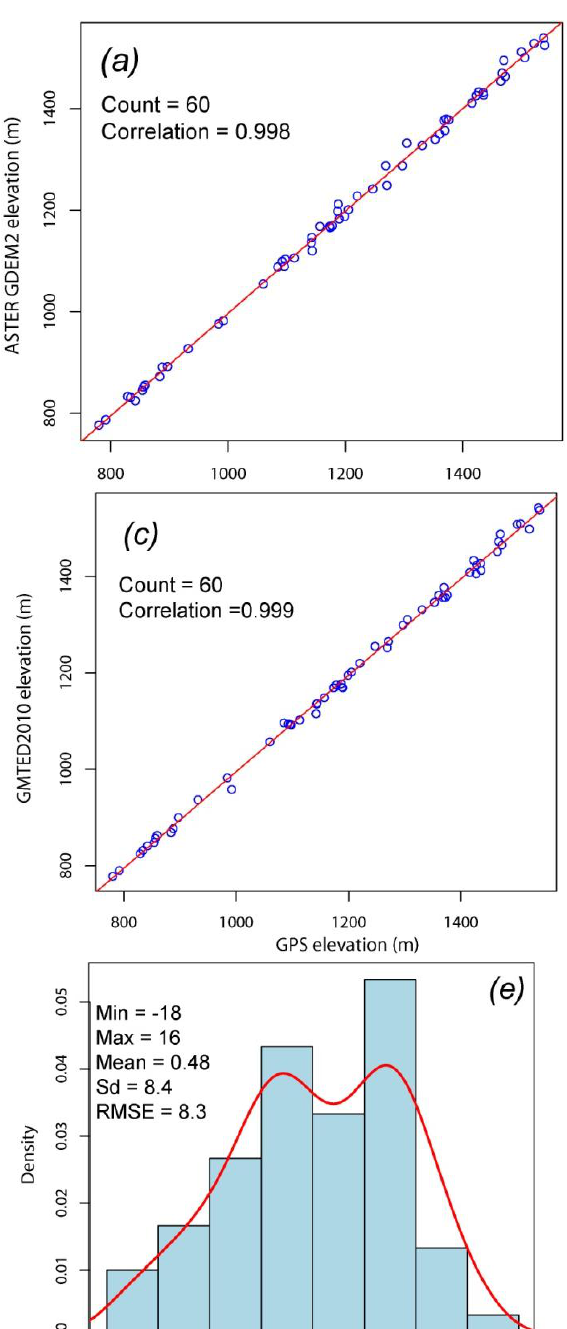
Figure 8. Summary statistics for Tebessa test site. Scatter plots of GNSS elevations vs. ( a ) ASTER GDEM2, ( b ), SRTM v4.1 and ( c ) GMTED2010. The red line stands for the line of perfect fit. Histograms of elevation errors and relevant descriptive statistics: ( d ) ASTER GDEM2 minus GNSS elevations, ( e ) SRTM v4.1 minus GNSS elevations and ( f ) GMTED2010 minus GNSS elevations. The solid red line represents the fitted density